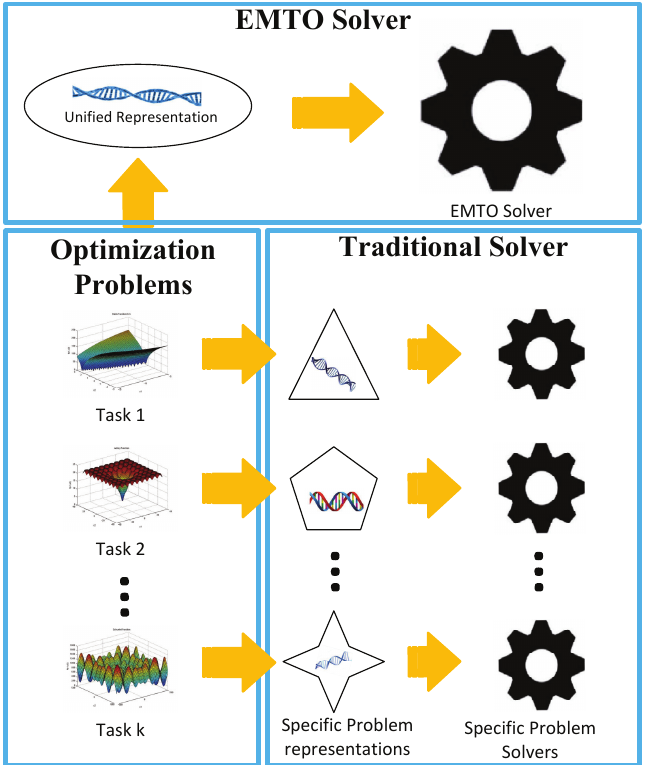
Figure 1. Highlighting the distinction between EMTO and traditional evolutionary optimization. In EMTO, all task-specific search spaces will be encoded within a unified representation space. An EMTO solver will simultaneously optimize all involved problems within this unified space, and output the found best solutions for all problems. Contrarily, traditional optimization independently optimizes each problem in a problem-specific search